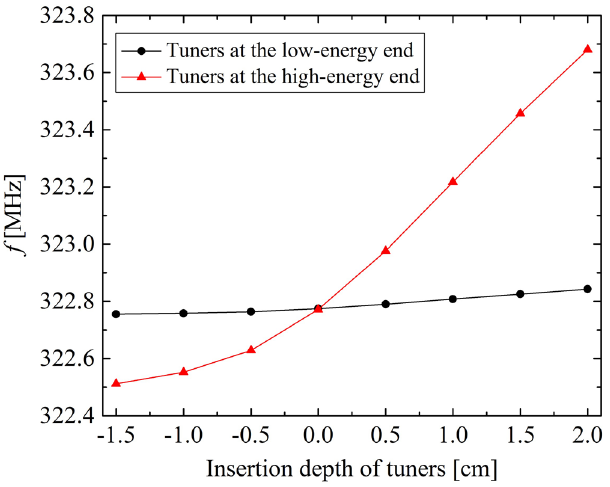
FIG. 10. Measured relationship between the coupling coeffi- cient β , resonant frequency f and angle θ .